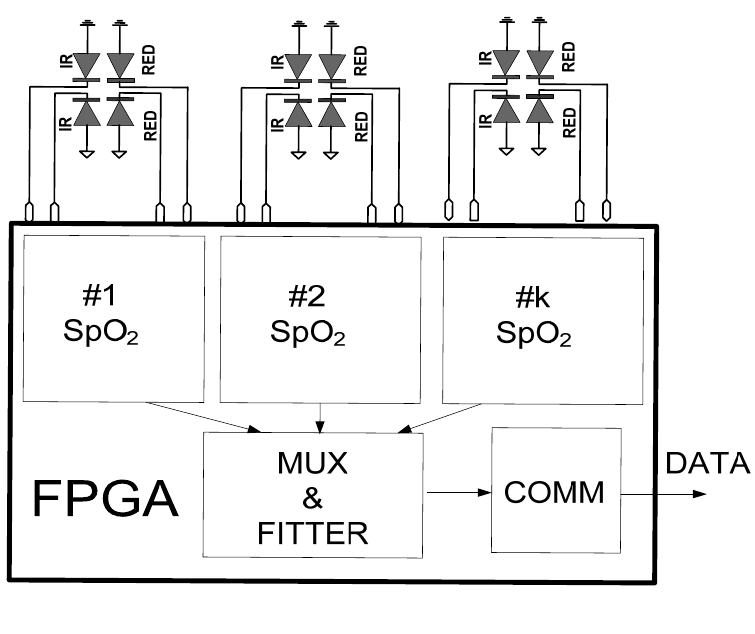
O system implanted in a single FPGA p 2